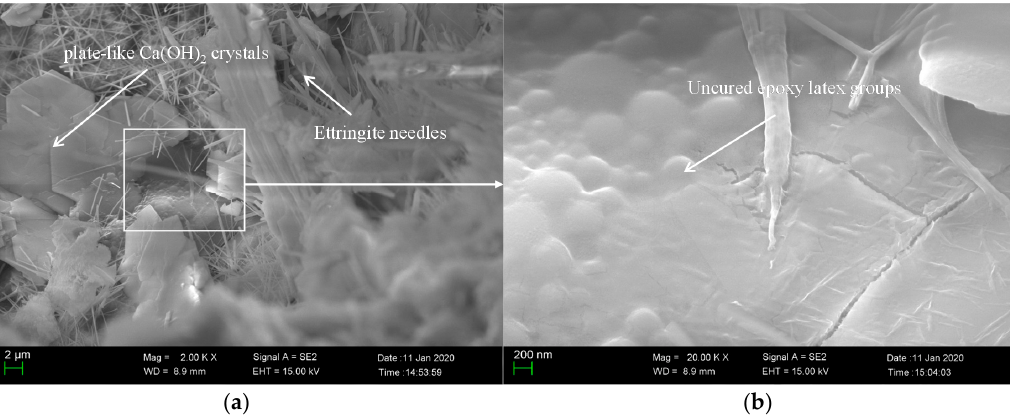
Figure 12. SEM image of fractured sections of epoxy latexes modified cement mortar under wet curing regimes with the addition of 15% epoxy resin at 45 d: ( a ) 5000× and ( b ) 20,000×.